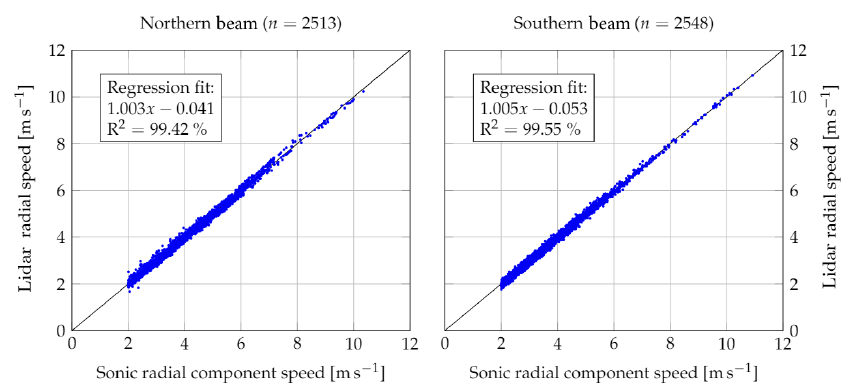
Figure 4. 10min average sonic radial component speed versus lidar wind speed. The lidar wind speed has been calculated using the centroid method.